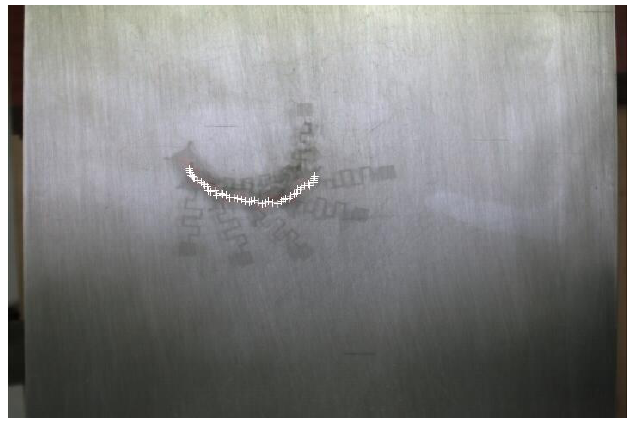
Figure 9. Sample trajectory of robot at 1,090 Hz.